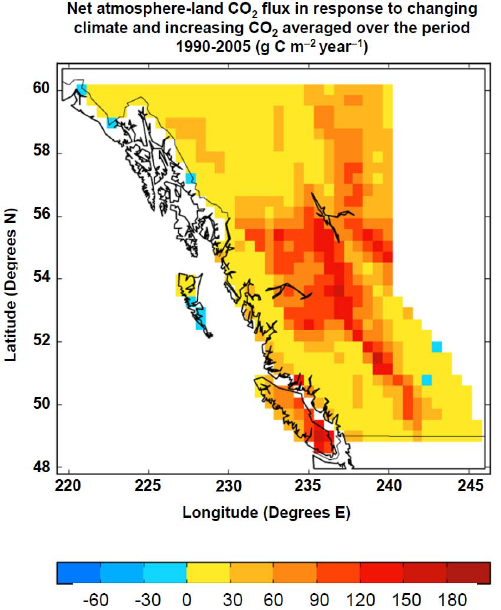
Fig. 6. Annual mean simulated net atmosphere–land CO 2 flux, in response to changing climate and CO 2 concentration for the period 1990–2005. Results are from the CLIM + CO 2 simulation and units are gCm − 2 yr − 1 . Positive values indicate a carbon sink over land, and negative values imply a source of carbon to the